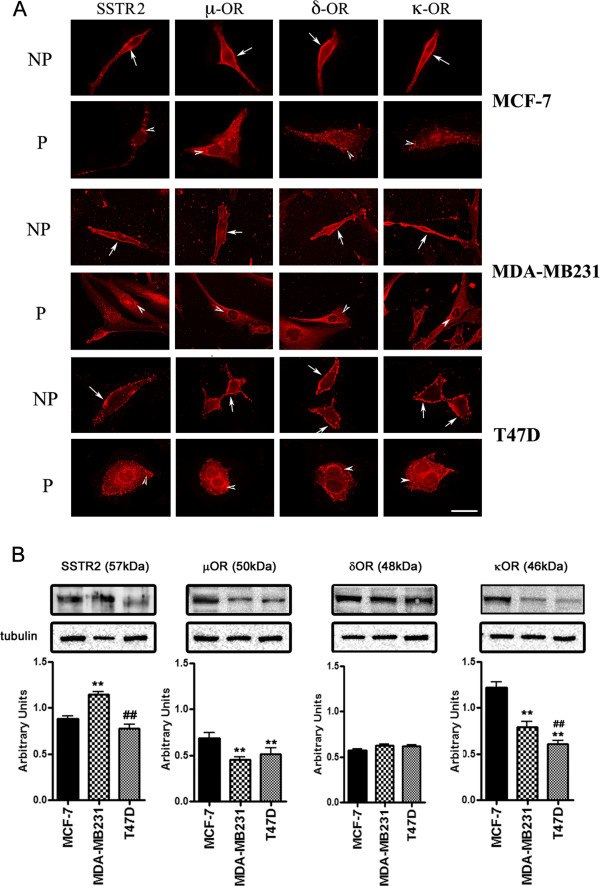
Differential expression of SSTR2 and μ, δ, κ-ORs in human breast cancer cells. (A) Indirect immunofluorescence staining showing membrane (non-permeabilized, NP) and intracellular (permeabilized, P) expression of SSTR2 and μ, δ, κ-ORs in breast cancer cells. In the representative panels receptor expression at the cell surface is indicated by arrows whereas arrowheads indicate intracellular expression. (B) Cell membrane extracts obtained from MCF-7, MDA-MB231 and T47D breast cancer cells were subjected to Western blot analysis and probed with specific primary antibodies to detect the receptor expression. The immunoblots show differential expression of SSTR2 (~57 kDa) and μ (~50 kDa), δ (~48 kDa), κ (~46 kDa)-ORs in a cell specific manner. Histogram represents densitometric analysis of the receptor expression normalized by using tubulin as loading control. Results are expressed as mean ± SEM (n = 3). **p < 0.01, MCF-7 vs. MDA-MB231 or T47D cells; ##p < 0.01; MDA-MB231 vs. T47D. Scale bar 10 μm.